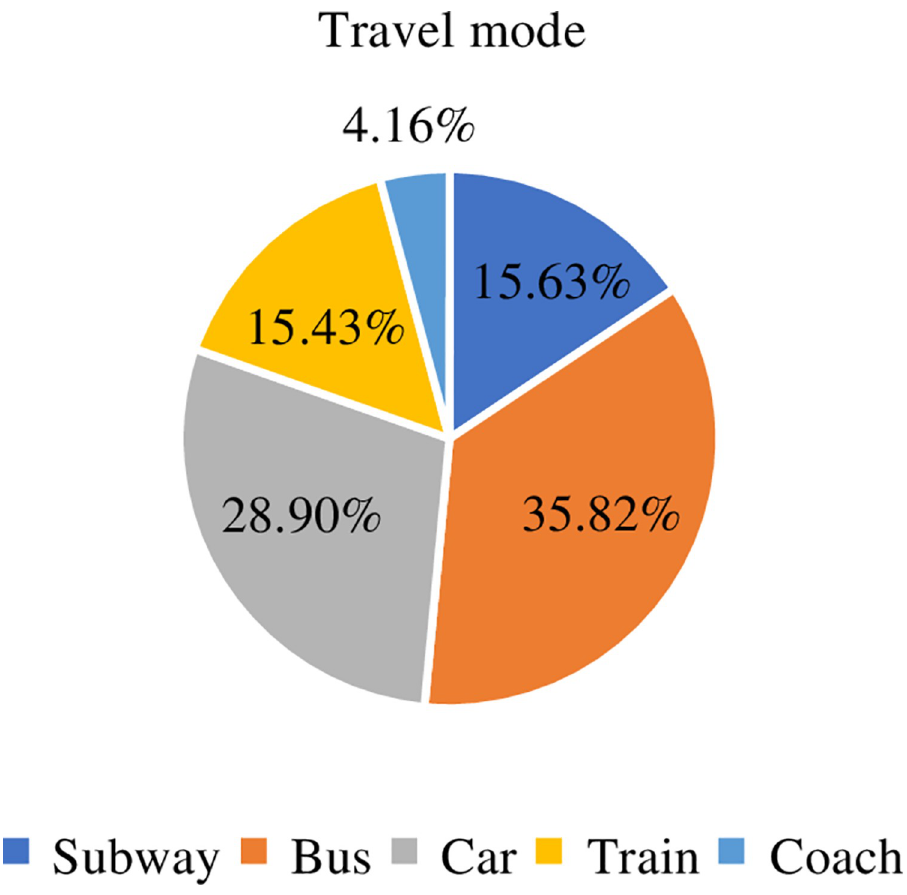
Fig 7. Distribution of travel modes in Beijing metropolitan